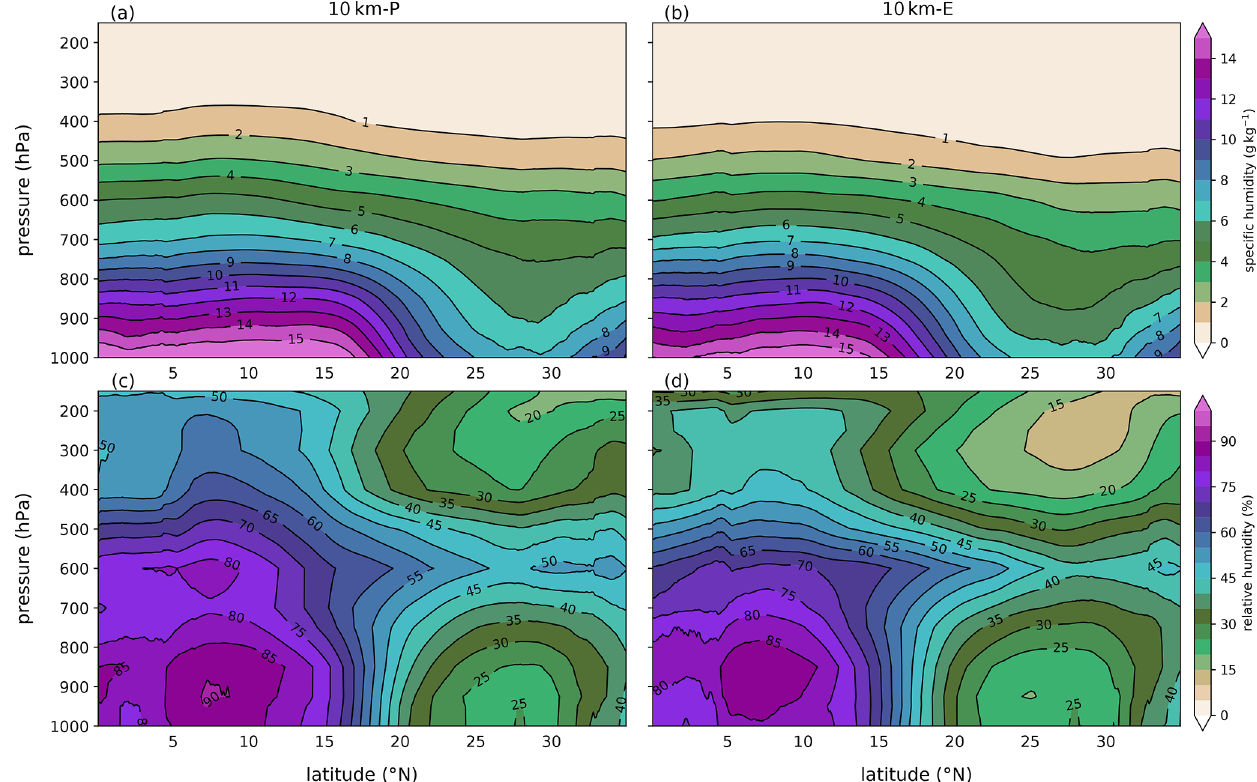
Figure A3. The same as Fig. 8 but for the 10km-P and 10km-E simulations.